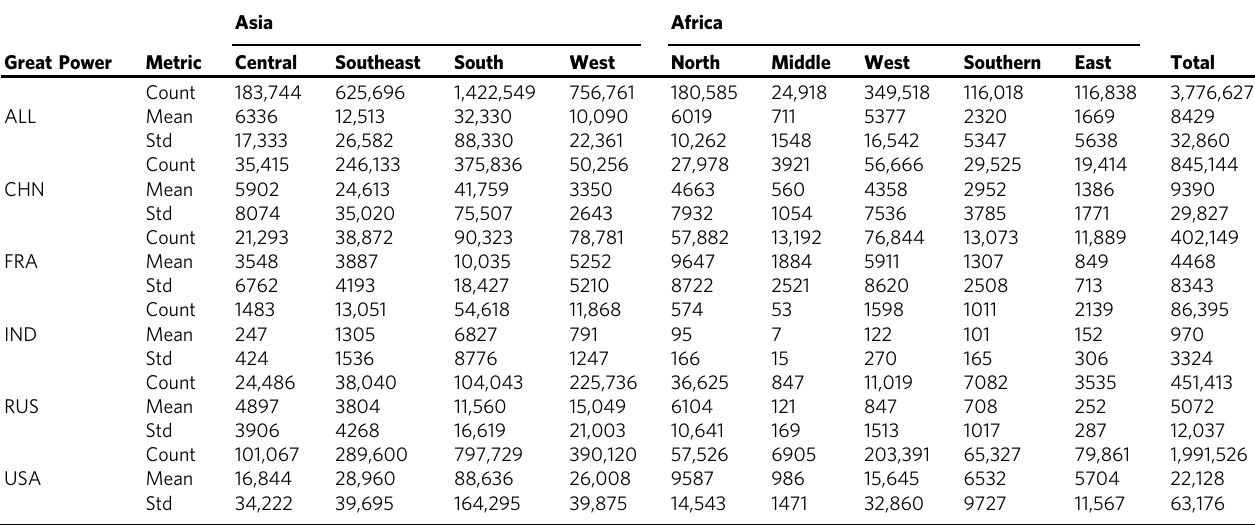
Table 1 Summary statistics on number of articles written about an actor from China, Russia, USA, India, or France between March 2015 and March 2021 by local presses in African and Asian Countries, sourced from (GDELT, 2015) and calculations made by the